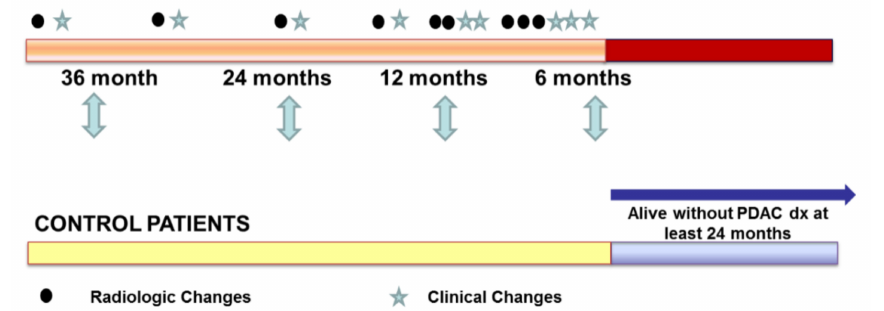
Figure 2. Study flow of clinical and radiologic